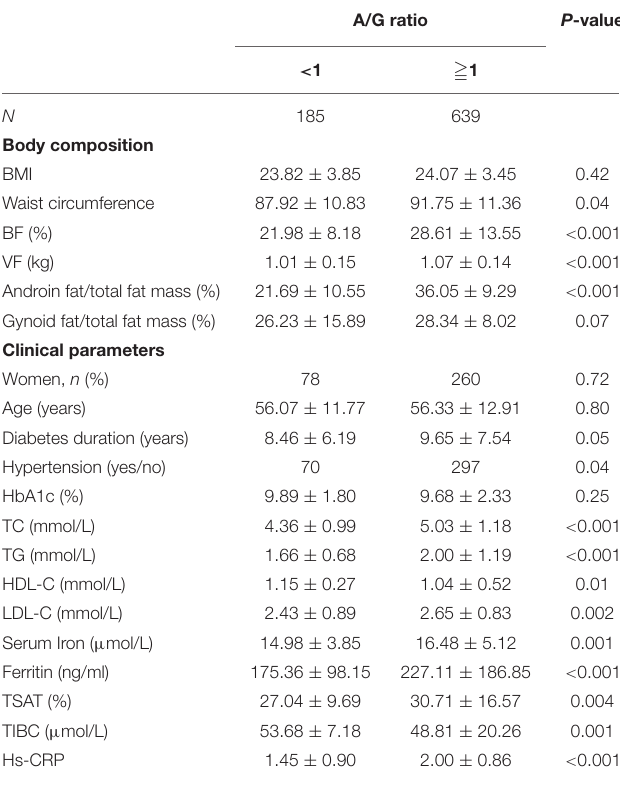
TABLE 2 | Baseline characteristics of study participants according to A/G ratio.